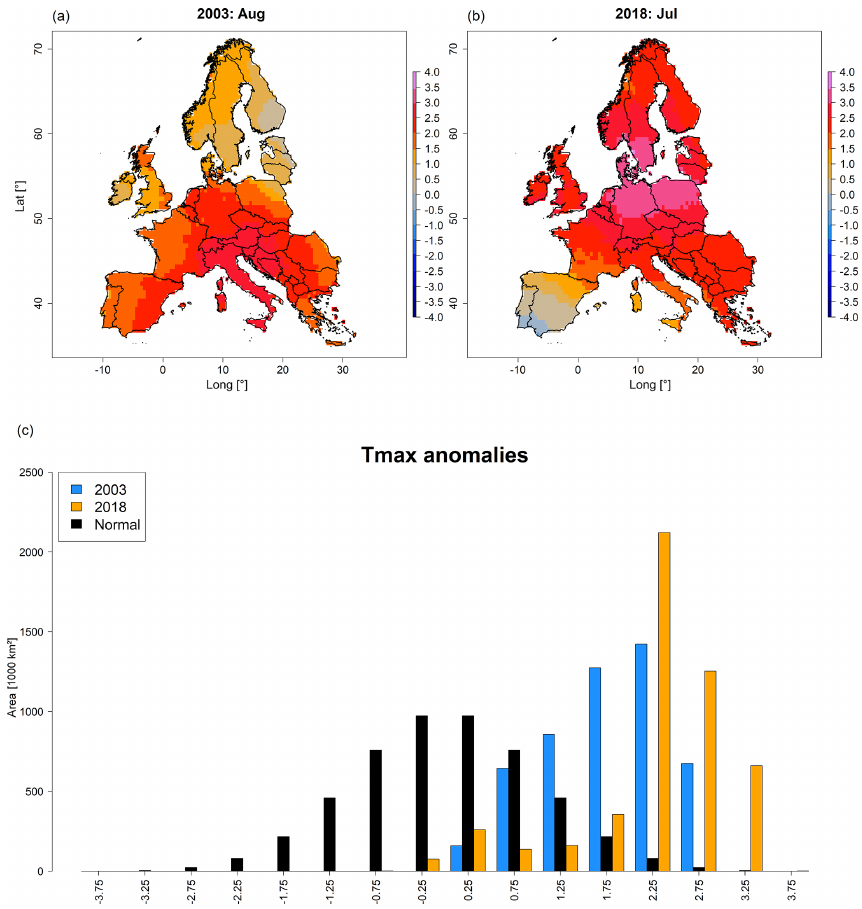
Figure 2. Maps depicting standardized anomalies of T max for August 2003 and July 2018 (a, b) as well as corresponding area histograms (in units of thousands of square kilometres) for 2003 (blue) and 2018 (orange), compared to a normal distribution (black) (c) . Shades of blue in (a) and (b) indicate relatively cool conditions, whereas shades of red indicate warmer conditions in comparison to the 1981– 2018 mean. Time series depicting the temporal development of T max anomalies for northern, central, and southern Europe are shown in Fig. S5. A video depicting the spatio-temporal development of T max anomalies from January through October is provided in Video V1